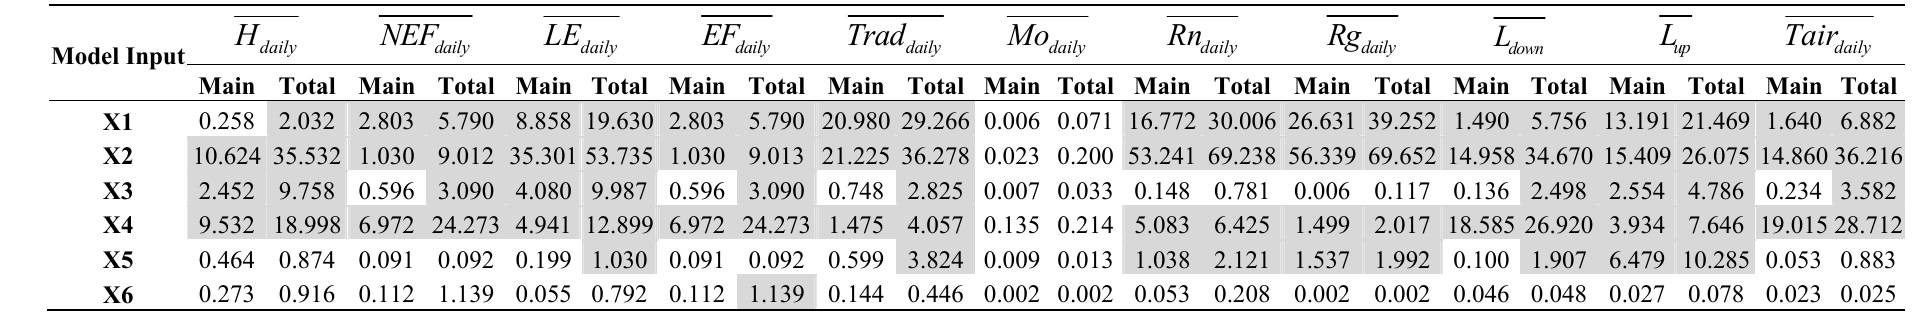
Table 7. Summarised results from the implementation of the BACCO GEM-SA method on the different outputs simulated by SimSphere using uniform PDFs at 13:30. Computed main (Main) and total effect (Total) indices by the GEM tool (expressed as %) for each of the model parameters are shown, whereas the last three lines summarise the percentages of the explained total output variance of the main effects alone (ME), the 1st order interactions only (1st) and the 2nd or higher order interactions only (>1st). Input parameters with a variance decomposition of greater than 1% are